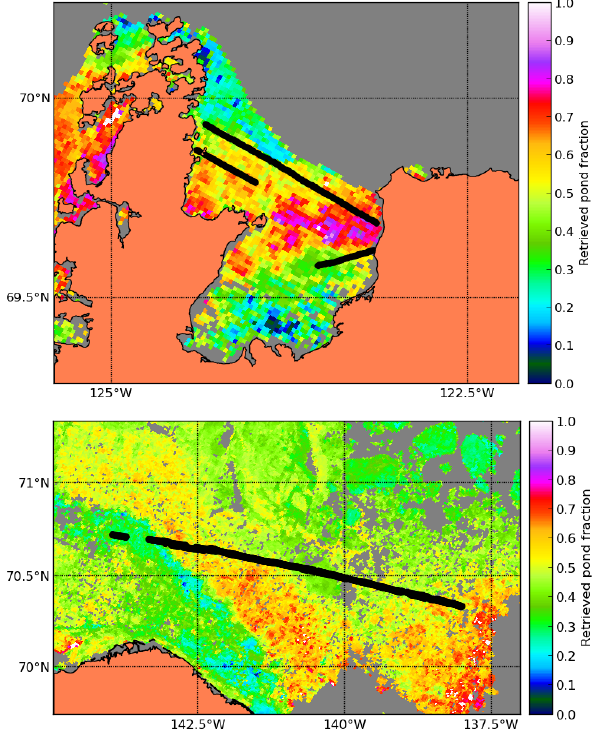
Figure 10. Examples of ice conditions present during MELTEX 2008 flights over landfast ice on 6 June 2008 (top panel) and over separate ice floes of various sizes on 4 June 2008 (bottom panel). Black dots: the flight track. The coloured filled background: the satellite retrieved melt pond fraction. The back- ground is the coral filled land mask and grey filled data gaps due to cloud contamination or surface type other than sea